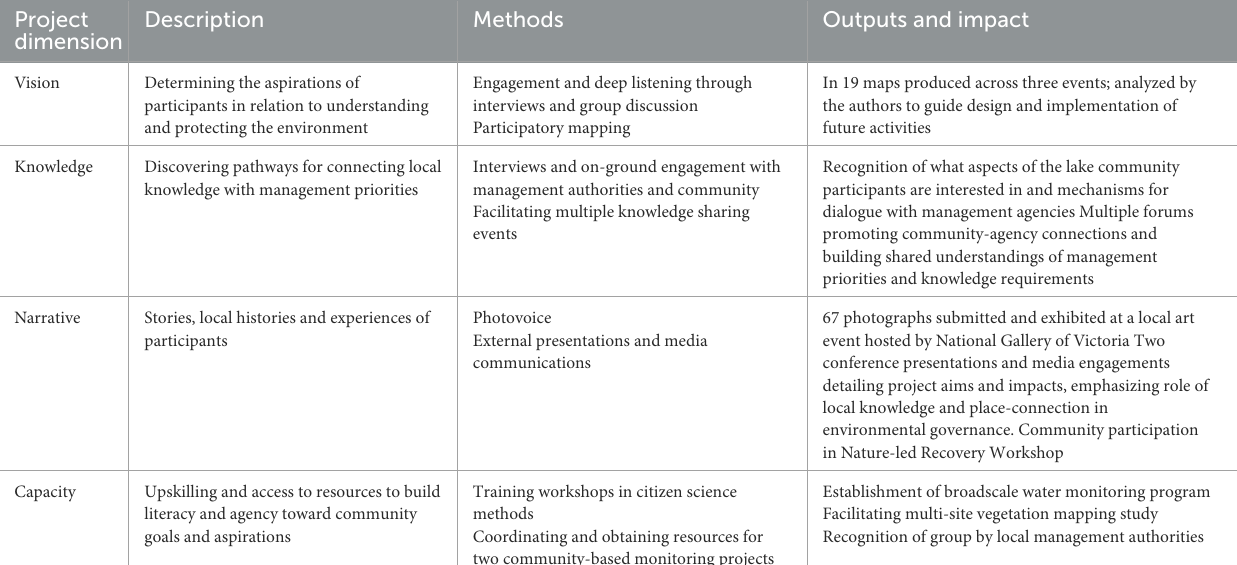
TABLE 1 Overview of project dimensions, methods, outputs, and impacts. Project dimension